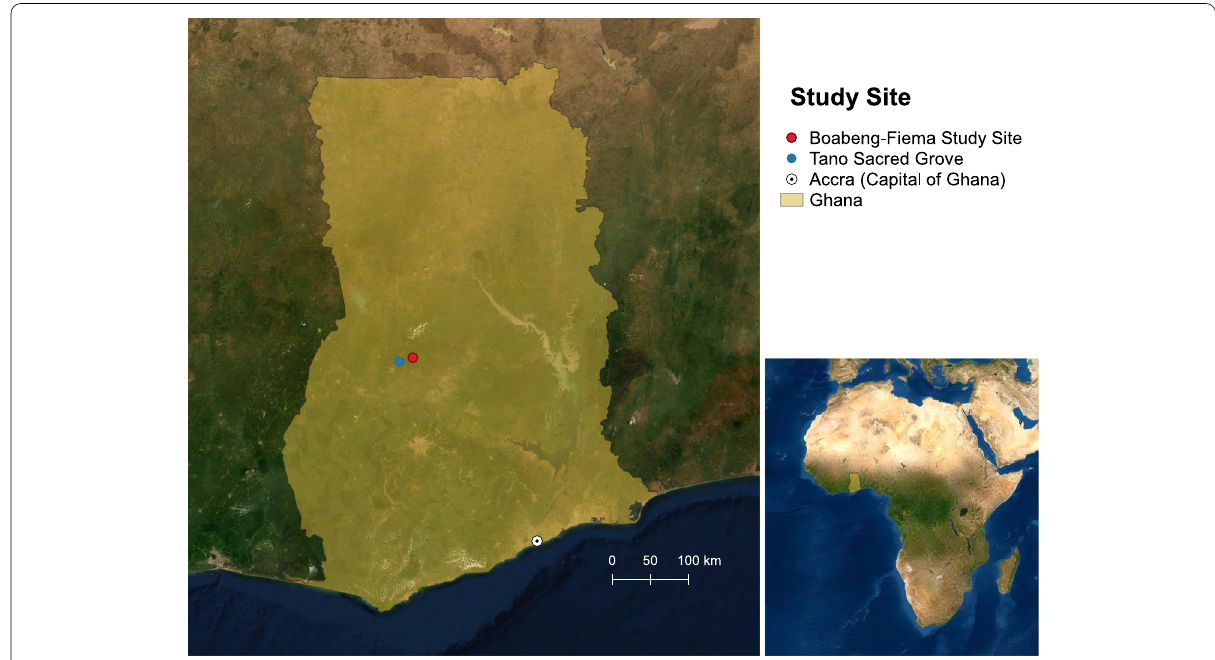
Fig. 1 Map of Ghana showing the study site at the villages of Boabeng and Fiema where bats and rodents were sampled from February 2017 – December 2018 and the nearby Tano Sacred Grove, a protected area that provides habitat for large colonies of fruit bats in Ghana. The bats and rodents were tested for five families of viruses with pandemic potential (coronaviruses, paramyxoviruses, flaviviruses, influenza viruses, and filoviruses). The villages of Boabeng and Fiema are located along the vegetative belt in the Bono East Region of